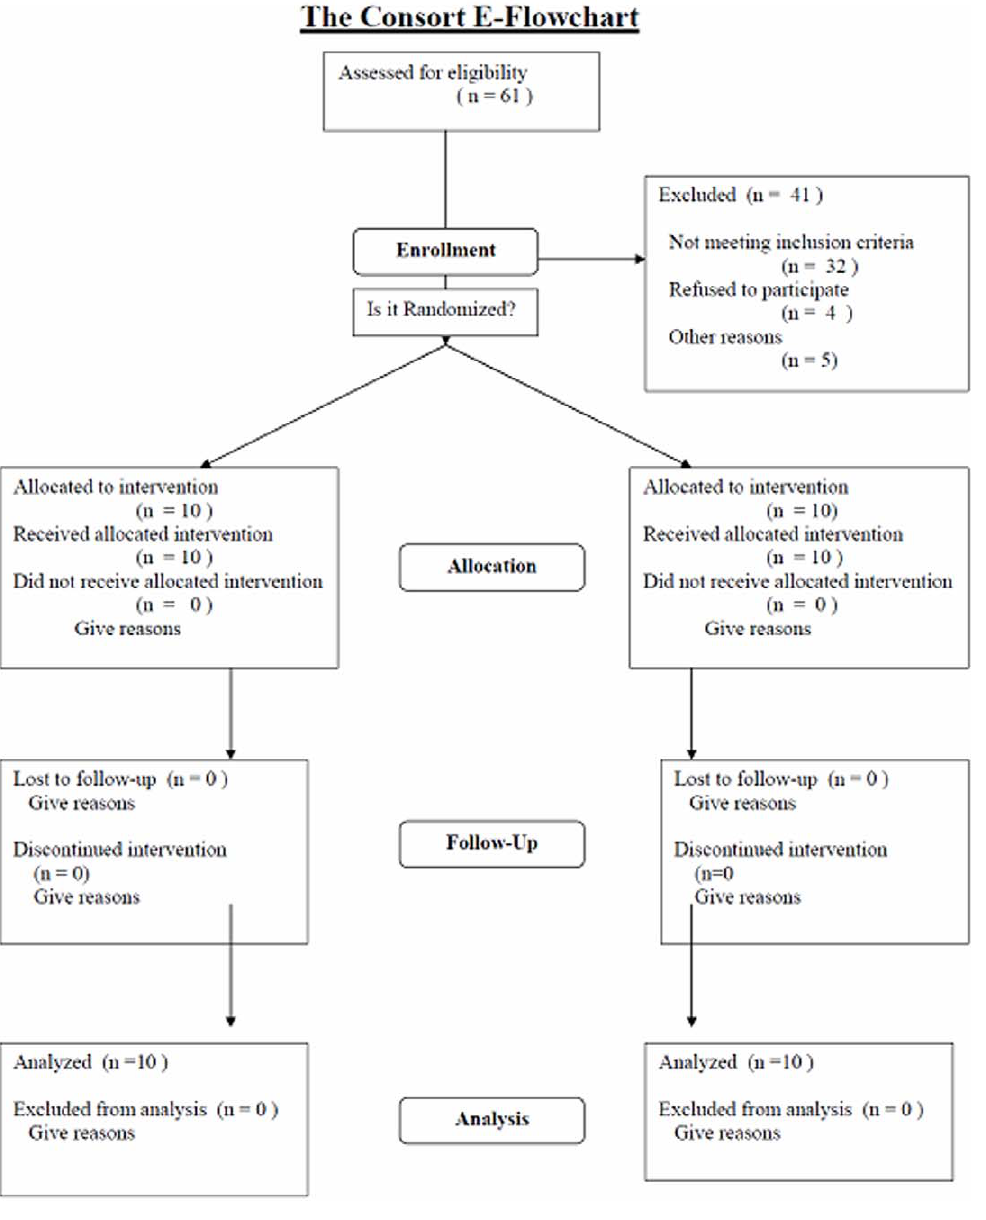
Figure 1. CONSORT flowchart.